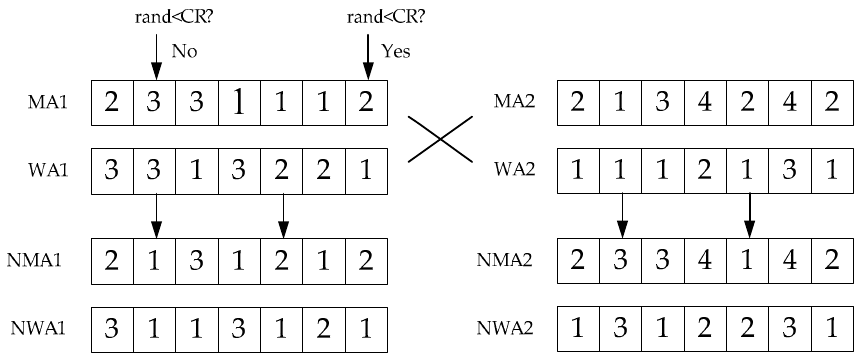
Figure 3. Random probability crossover operation.